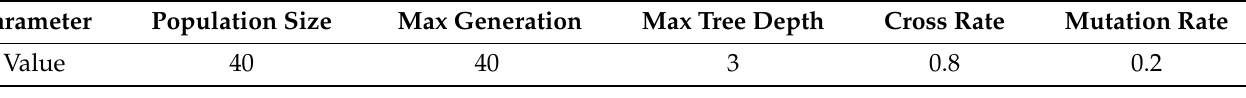
Algorithm 1: The genetic programming